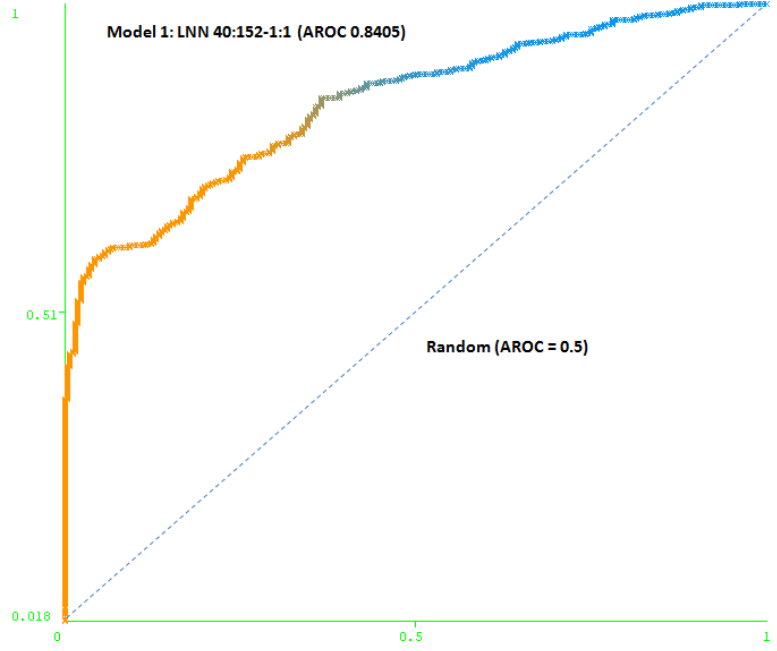
Figure 3. Area under the receiver operating characteristic curve (AUC-ROC) for LNN 40:152-1:1 (Model 1).